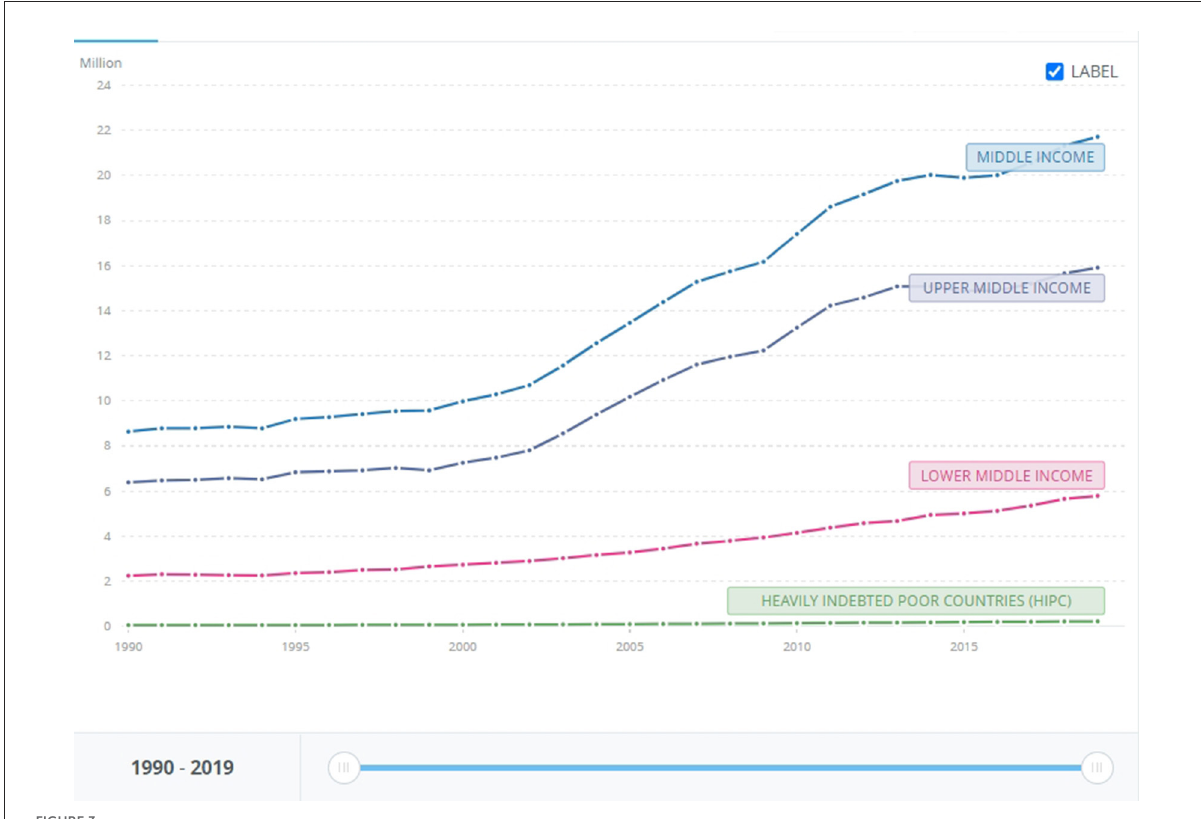
FIGURE3 CO2 emissions in relation to countries’ income worldwide. 1990-2019, Source: World Bank. At https://data.worldbank.org/indicator/EN.ATM. CO2E.KT?contextual=default&end=2019&locations=XP-XE-XT-XN&most_recent_year_desc=false&start=1990&view=chart (accessed August 9,